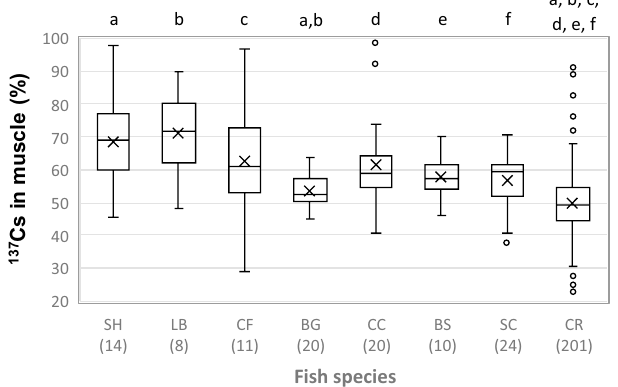
Figure 2. Boxplot showing the proportion of 137 Cs in muscle of 8 kinds of fishes. Abbreviations of SH, LB, CF, BG, CC, BS, SR, and CR are snakehead, largemouth bass, channel catfish, bluegill, common carp, barbel steed, silver carp, and crucian carp, respectively. The numbers in parentheses are the number of samples. Significant difference was found for the Kruskal–Wallis test ( P < 0.01). Lowercase letters above boxes indicate significant differences from the post-hoc Steel–Dwass